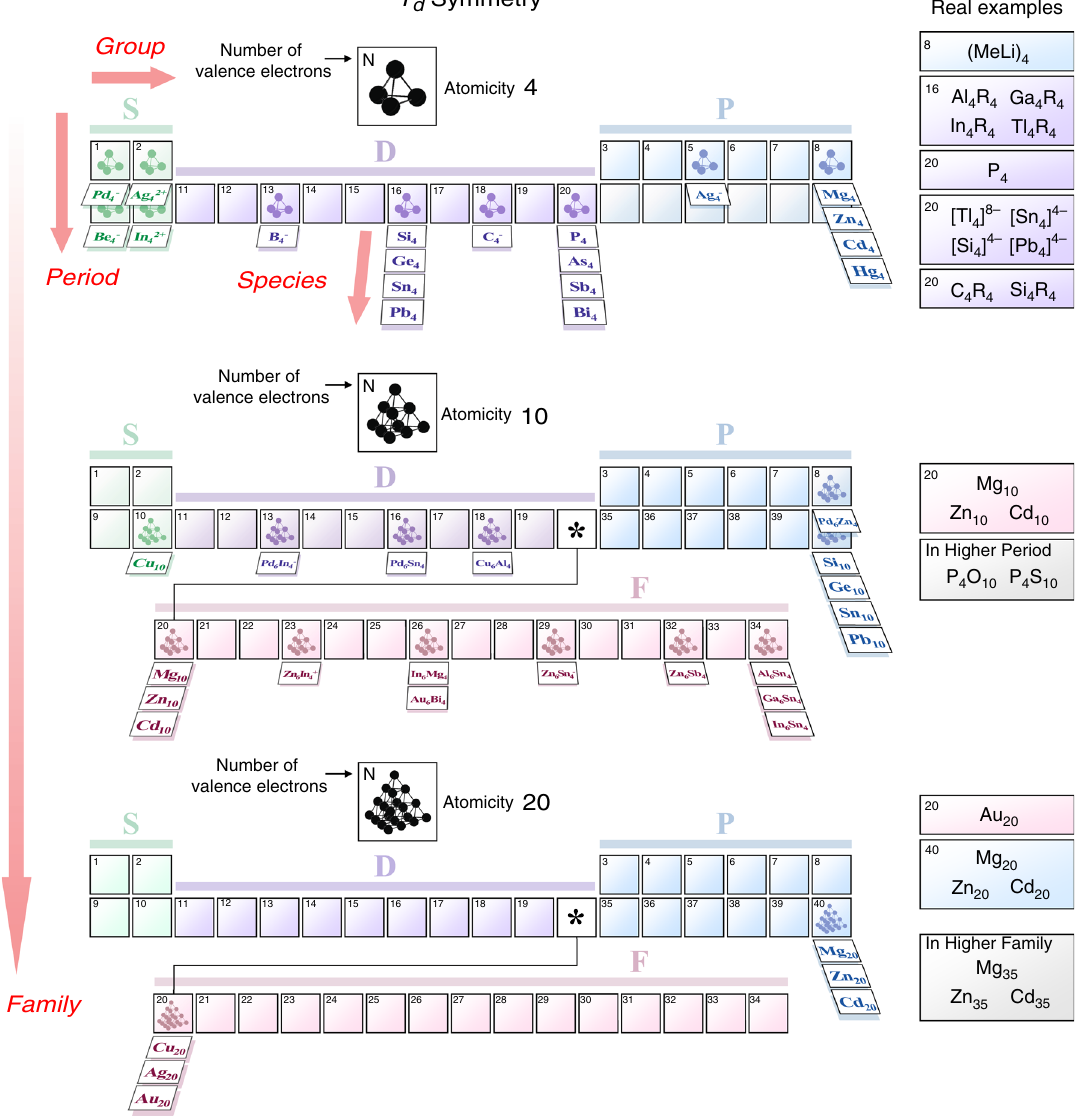
Fig. 6 The periodic framework based on the T d -type symmetry-adapted orbital (SAO) model. Groups and periods are de fi ned according to the outer-shell con fi gurations. Families and species classify clusters from the viewpoints of the number of constitutive atoms and the constitutive elements,